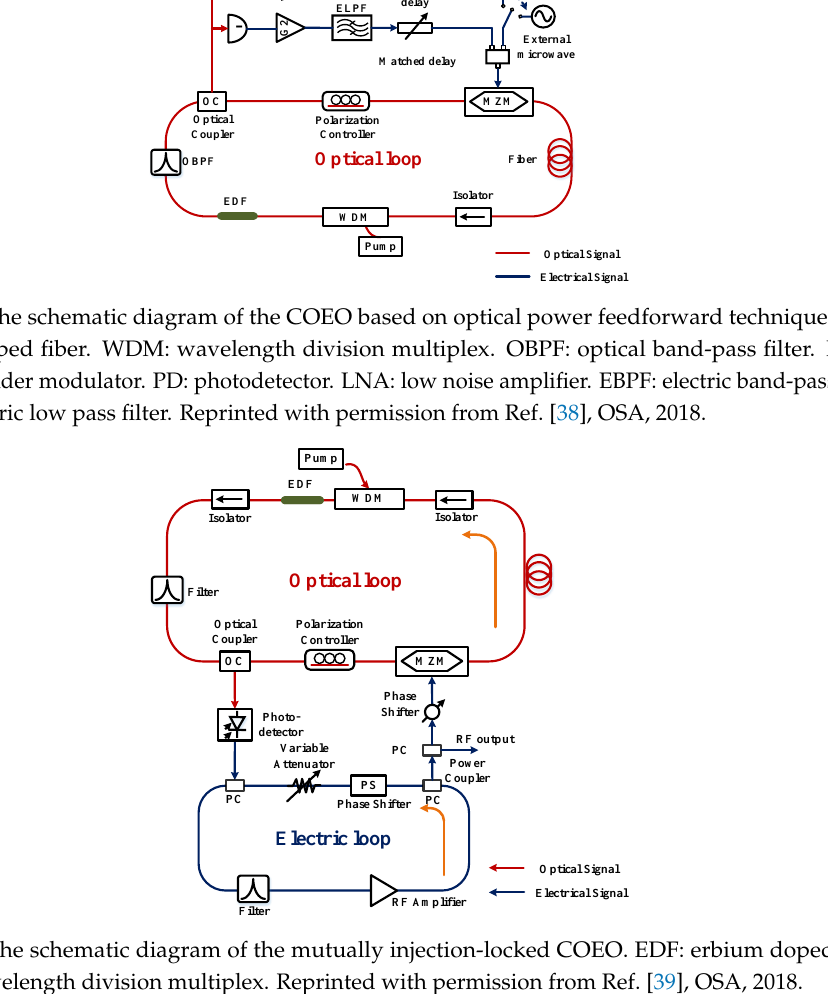
Figure 6. The schematic diagram of the mutually injection-locked COEO. EDF: erbium doped fiber. WDM: wavelength division multiplex. Reprinted with permission from Ref. [39], OSA, 2018 .